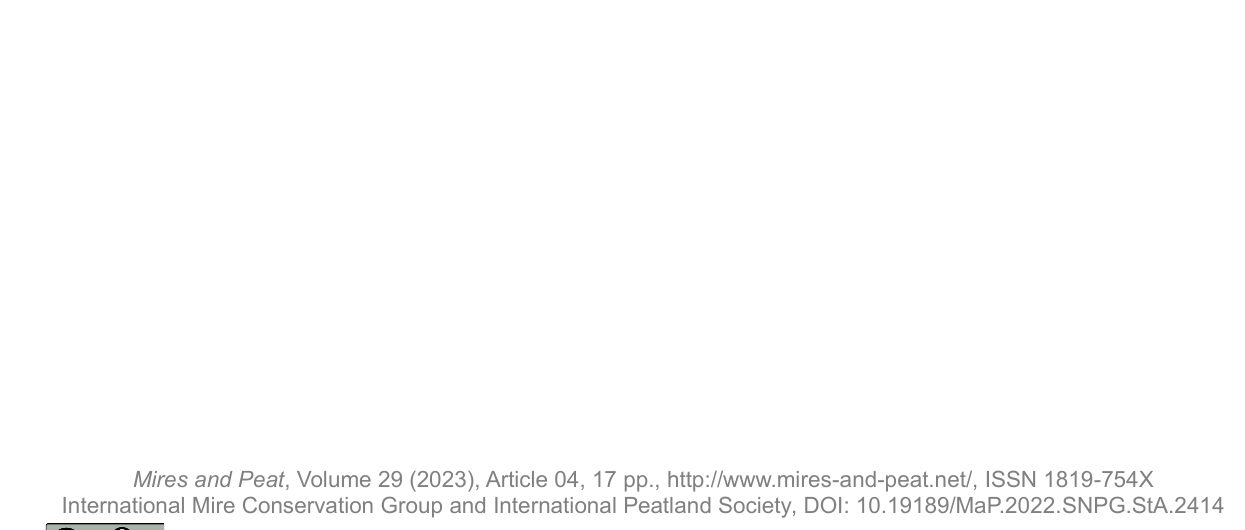
EF includes both CH and 4 4_land EF includes biomass export, 2